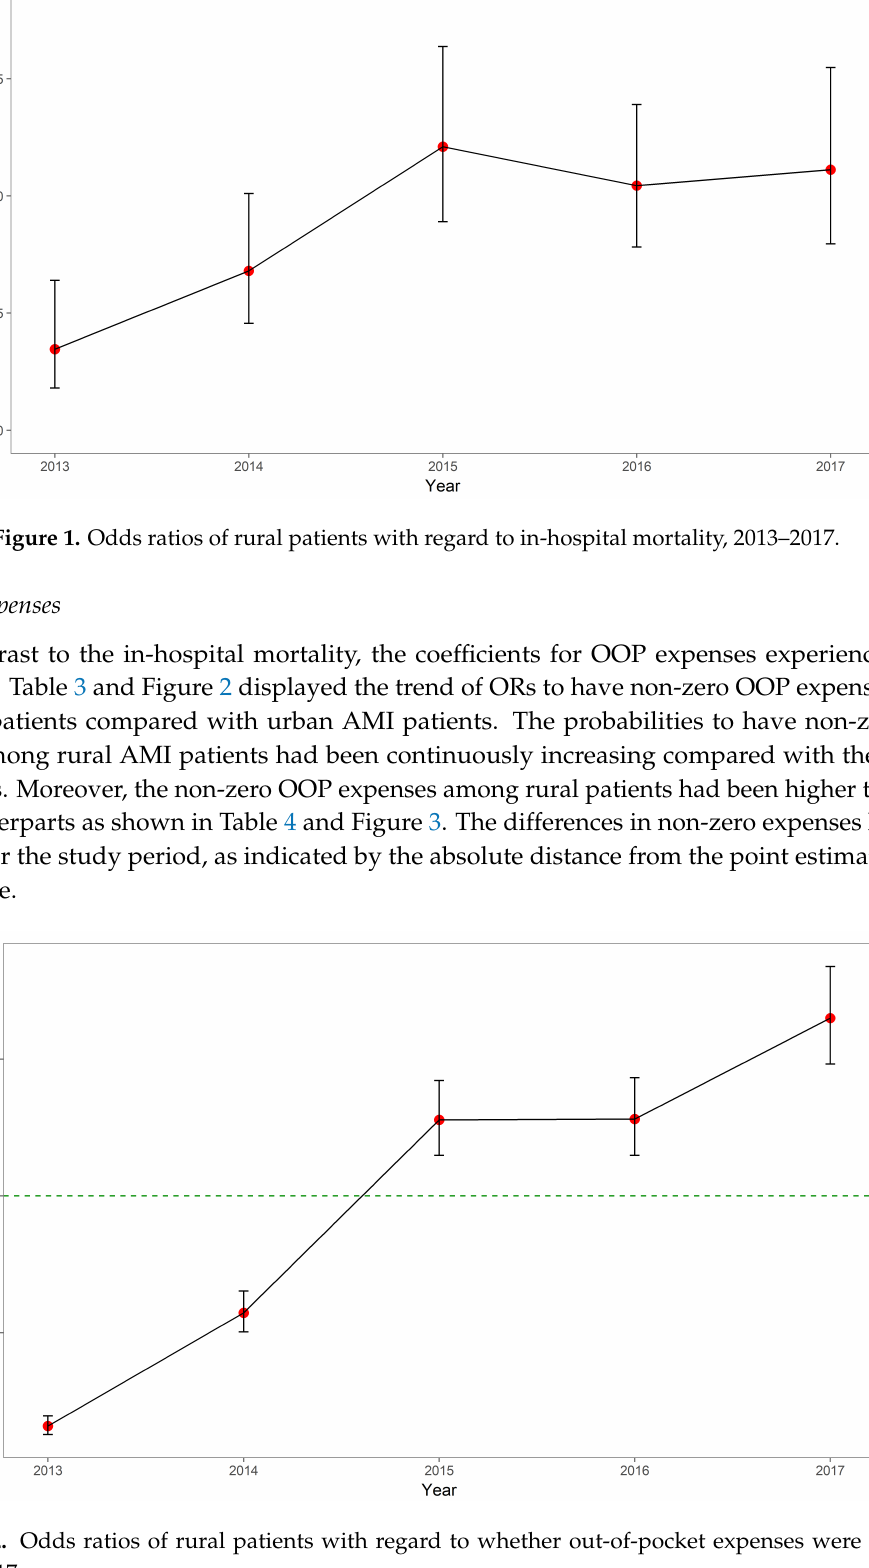
Figure 2. Odds ratios of rural patients with regard to whether out-of-pocket expenses were zero,